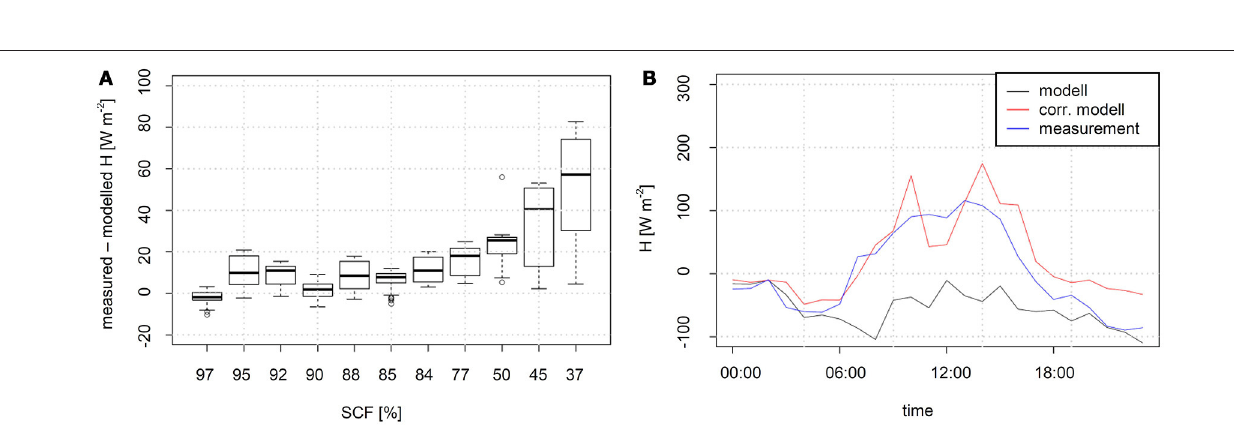
FIGURE 7 | Near-surface air temperatures [K] (top panels) for the Gletschboden area for the 20 May 2014 12 UTC as input in Alpine3D before applying the temperature footprint approach (A) and after applying the temperature footprint approach (B) . Modeled snow ablation rate [m day − 1 ] for the Gletschboden area for the 20 May 2014 (bottom panels) before applying the temperature footprint approach (C) and after applying the temperature footprint approach (D) .